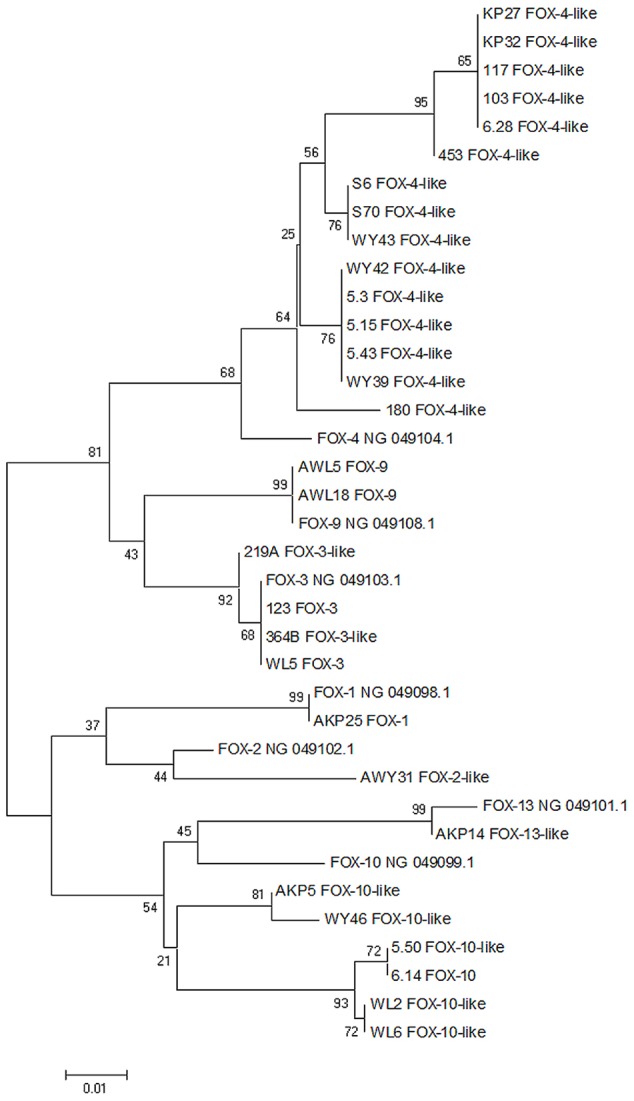
Neighbor joining dendrogram tree based on blaFOX gene sequences of Aeromonas spp. isolated from WWTP. Seven GenBank reference blaFOX sequences also have been attached to the analysis (sequences with NG numbers). The branch numbers refer to the percent confidence as estimated by bootstrap analysis with 1000 replications.